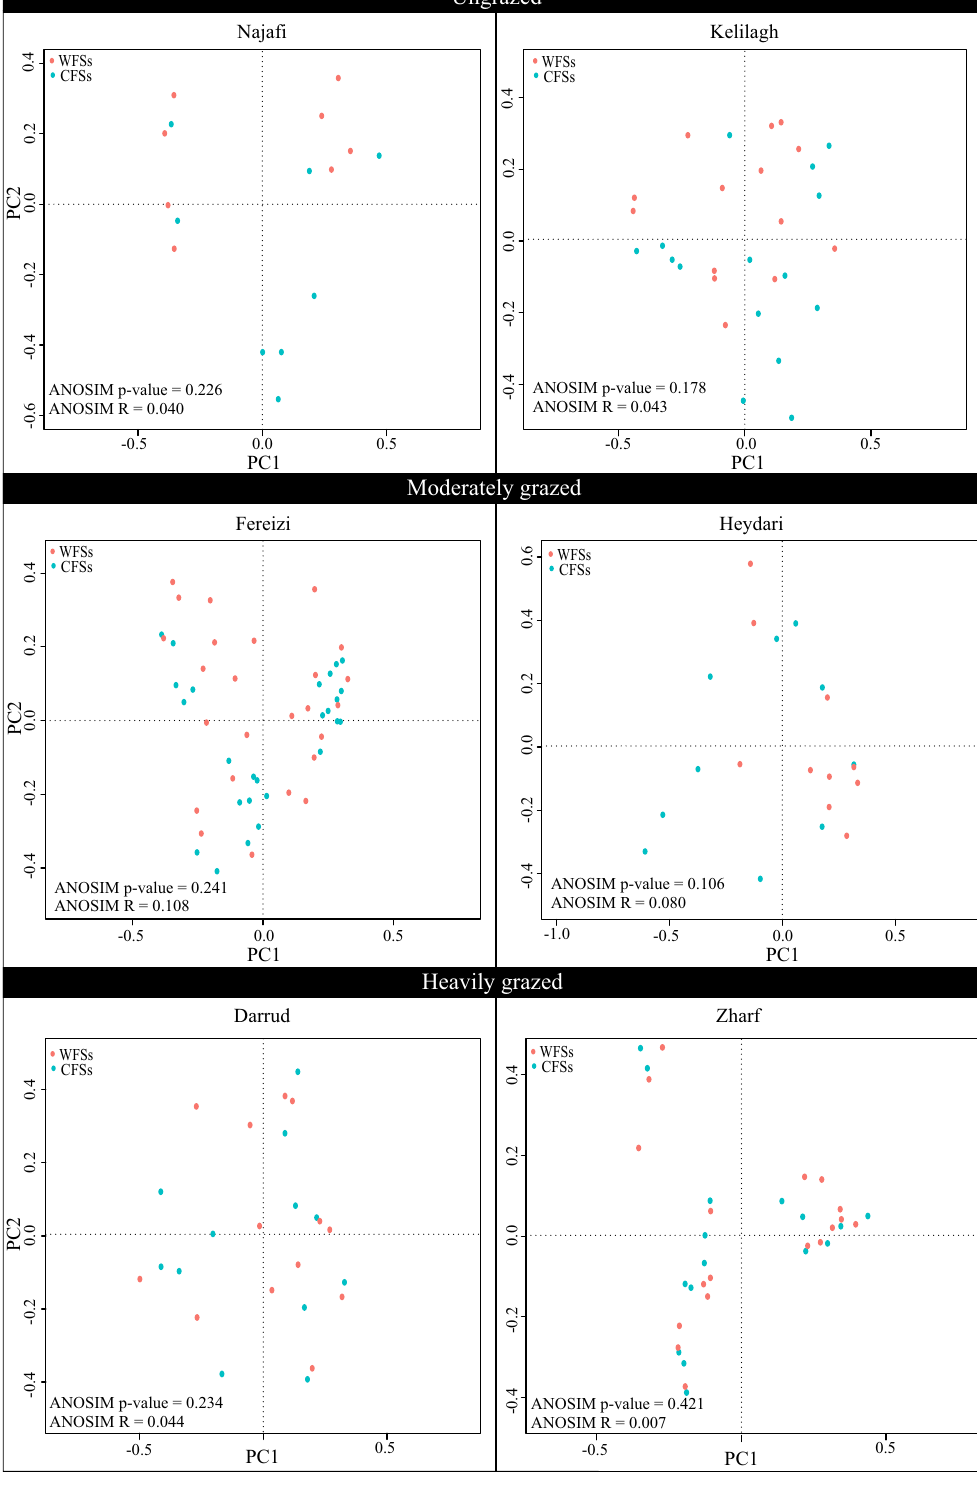
Figure 3. Transformation-based principal component analysis and analysis of similarity (ANOSIM) results showing the species composition differences in plant communities containing (CFSs) and without (WFSs) Phlomis cancellata in six